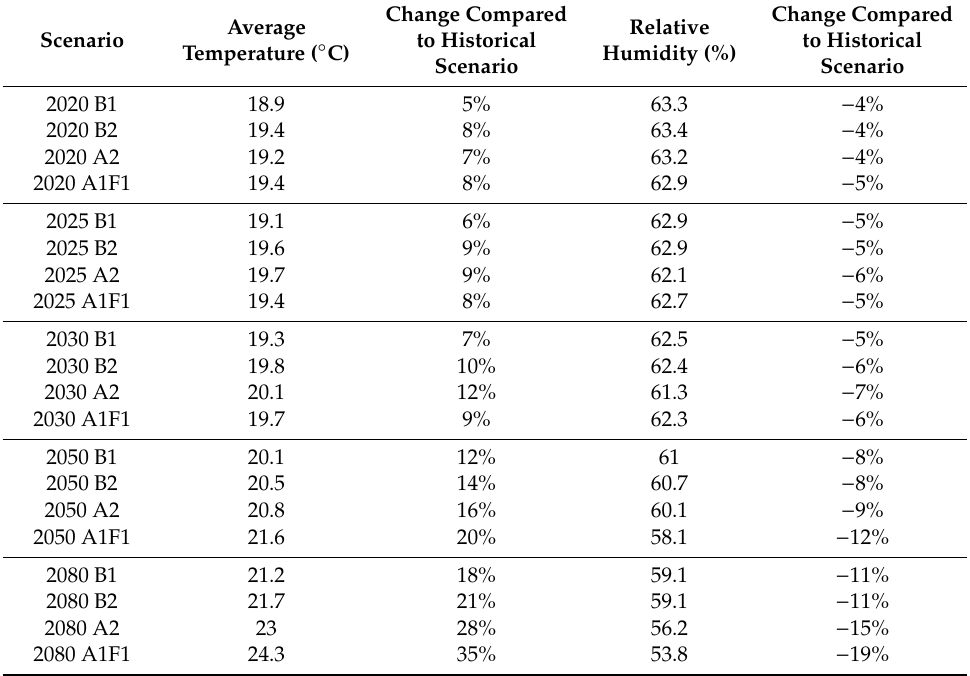
Table A1. Summary of average temperature and relative humidity in present and future scenarios and